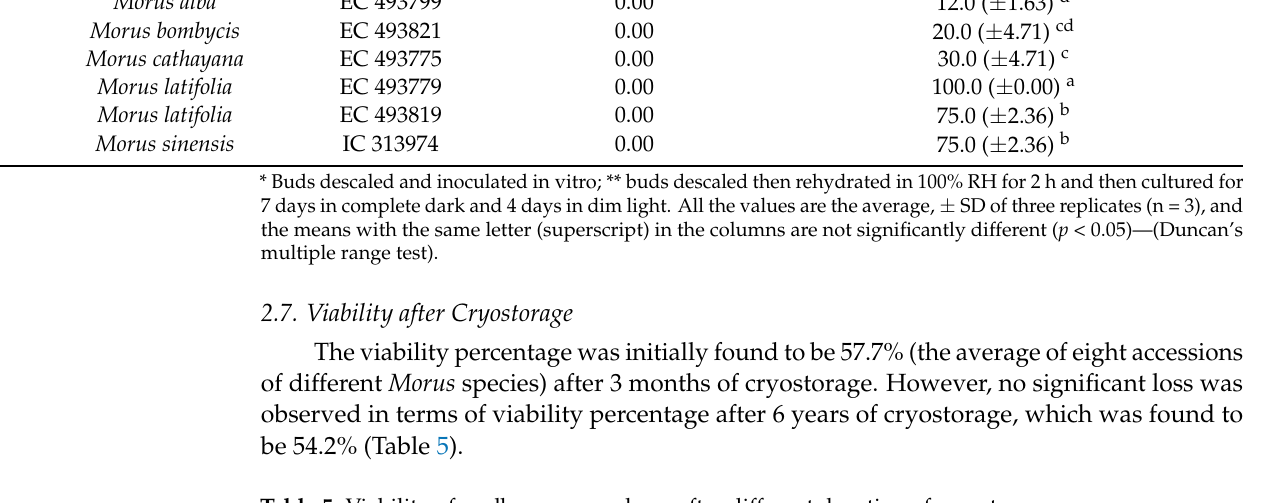
Table 5. Viability of mulberry germplasm after different duration of